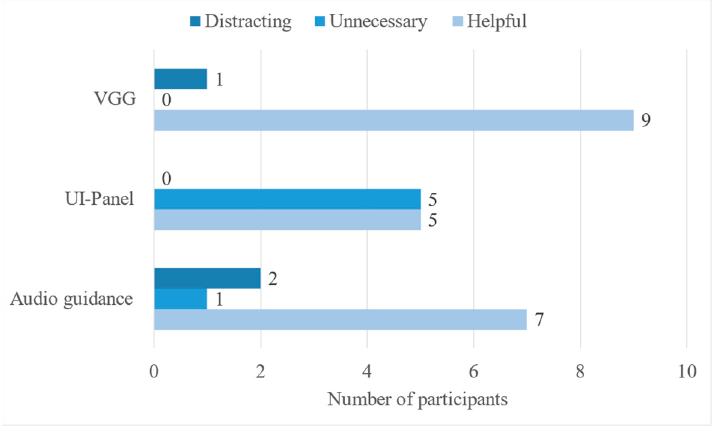
Figure 21. The participants’ perception of other guidance formats in the MR app.